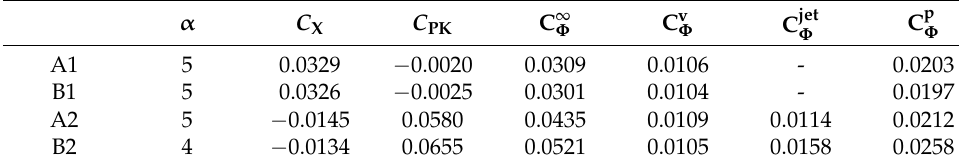
Table 3. Comparison of the aerodynamic dissipation rate